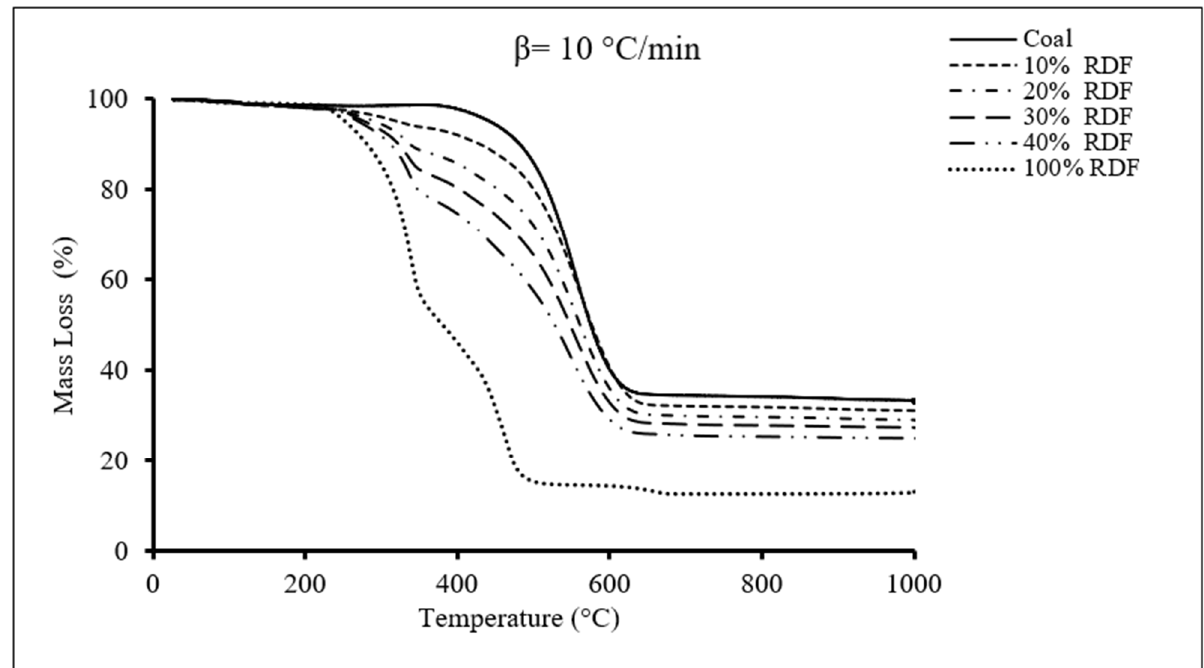
Figure 1. TGA profiles of coal, RDF, and coal/RDF blends for combustion process.